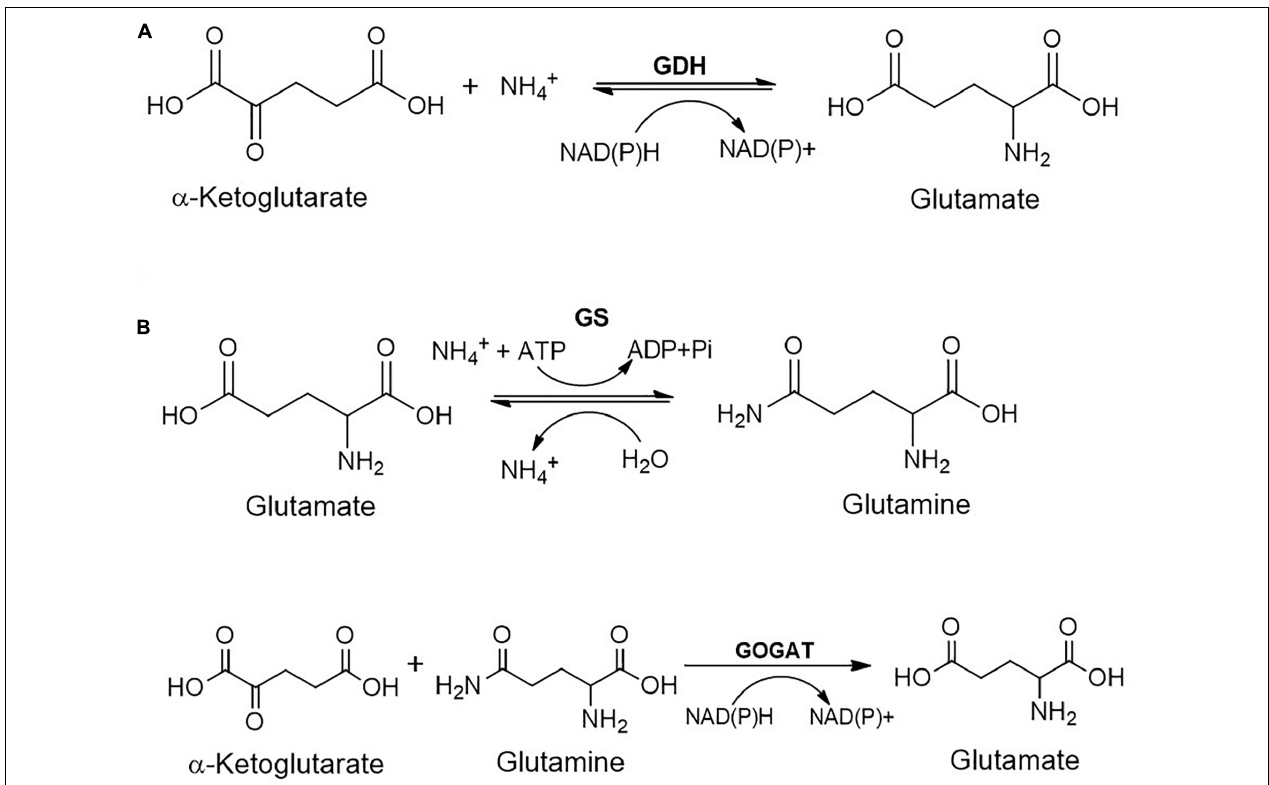
FIGURE 6 | Metabolic fate of ammonia generated during the carbamate metabolism: (A) Glutamate dehydrogenase (GDH); or (B) Glutamine synthetase/Glutamine oxoglutarate aminotransferase (GS/GOGAT)